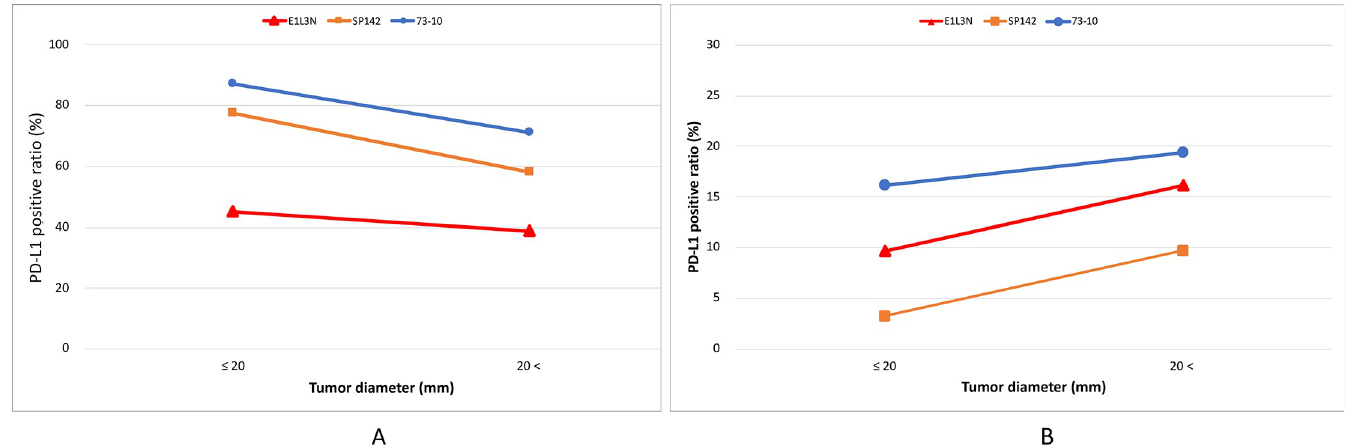
Fig 6. Comparison of PD-L1-positive ratio between immune cells (A) and tumor cells (B) based on tumor diameter. (Table 7A and 7B). The concordance rate between the SP 142 and E1L3N assays for tumors with diameter � 20 mm was 93.5%, and the Cohen’s kappa coefficient was 0.475 (moderate agreement, p = 0 . 002 ) (Table 7C). The concordance rates of the SP 142 and E1L3N assays with the 73–10 assay for tumors with diameter > 20 mm were 90.3% and 96.8%, and the Cohen’s kappa coefficients were 0.617 (substantial agreement, p < 0 . 001 ) and 0.890, respectively (per- fect agreement, p < 0 . 001 ) (Table 7D and 7E). The concordance rate between the SP 142 and E1L3N assays for tumors with diameter > 20 mm was 93.5%, and the Cohen’s kappa coeffi-